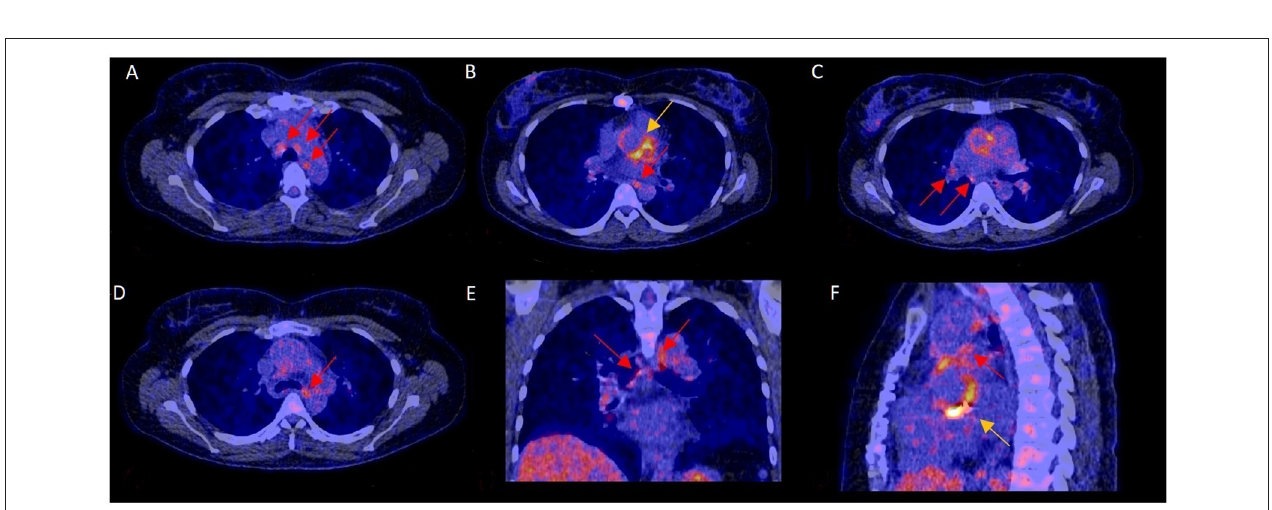
FIGURE 2 | 18 F-FDG-PET/CT scan with increased mediastinal lymph node FDG activity and confirmed PVE. In this 40–45 year-old female with blood culture-negative PVE, FDG uptake was markedly increased in mediastinal lymph nodes ( A–F : red arrows) and the aortic prosthetic valve ( B,F : yellow arrows). Surgery showed